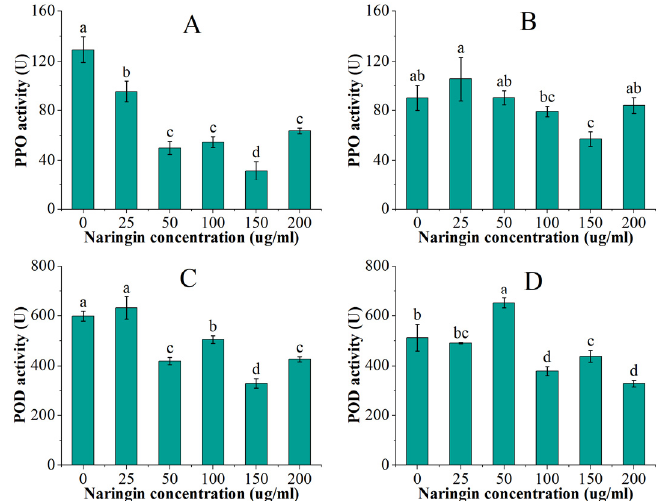
Figure 2. The PPO and POD activities of the mung bean sprouts. ( A ) PPO activity after 3 days of storage; ( B ) PPO activity after 6 days of storage; ( C ) POD activity after 3 days of storage; ( D ) POD activity after 6 days of storage. Bars with different letters indicate significant differences among the samples ( p < 0.05).